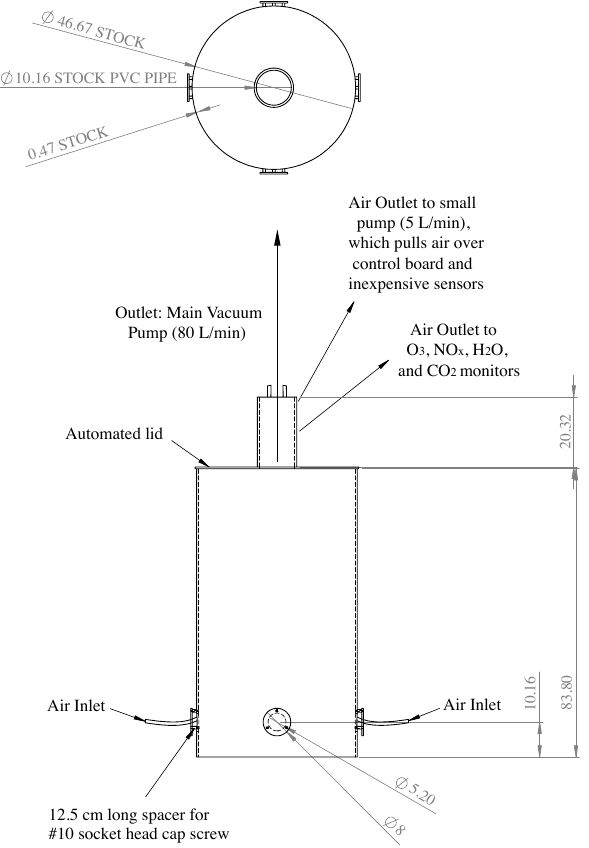
Figure 2. The plot above shows the dimensions of the chamber and the locations of the air inlets and